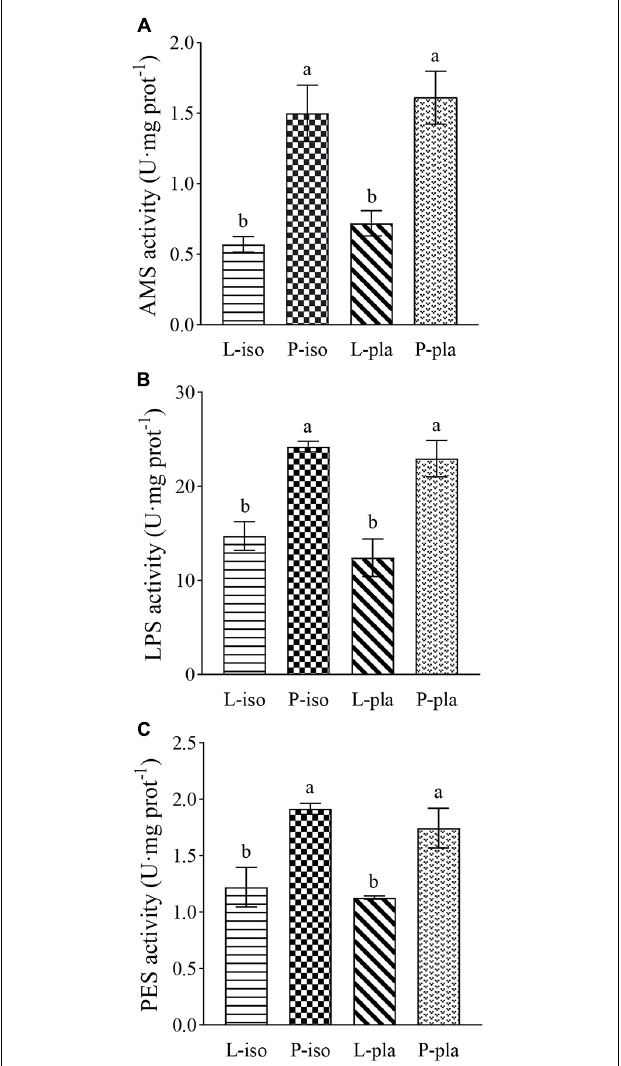
FIGURE 1 | The digestive enzyme activity of Pinctada maxima juvenile after 30-day industrial farming. The significance level of P < 0.05 was used for all statistical tests. Different lower-case letters indicate significant differences. (A) AMS activity, AMS = amylase; (B) LPS activity, LPS = lipase; (C) PES activity, PES =